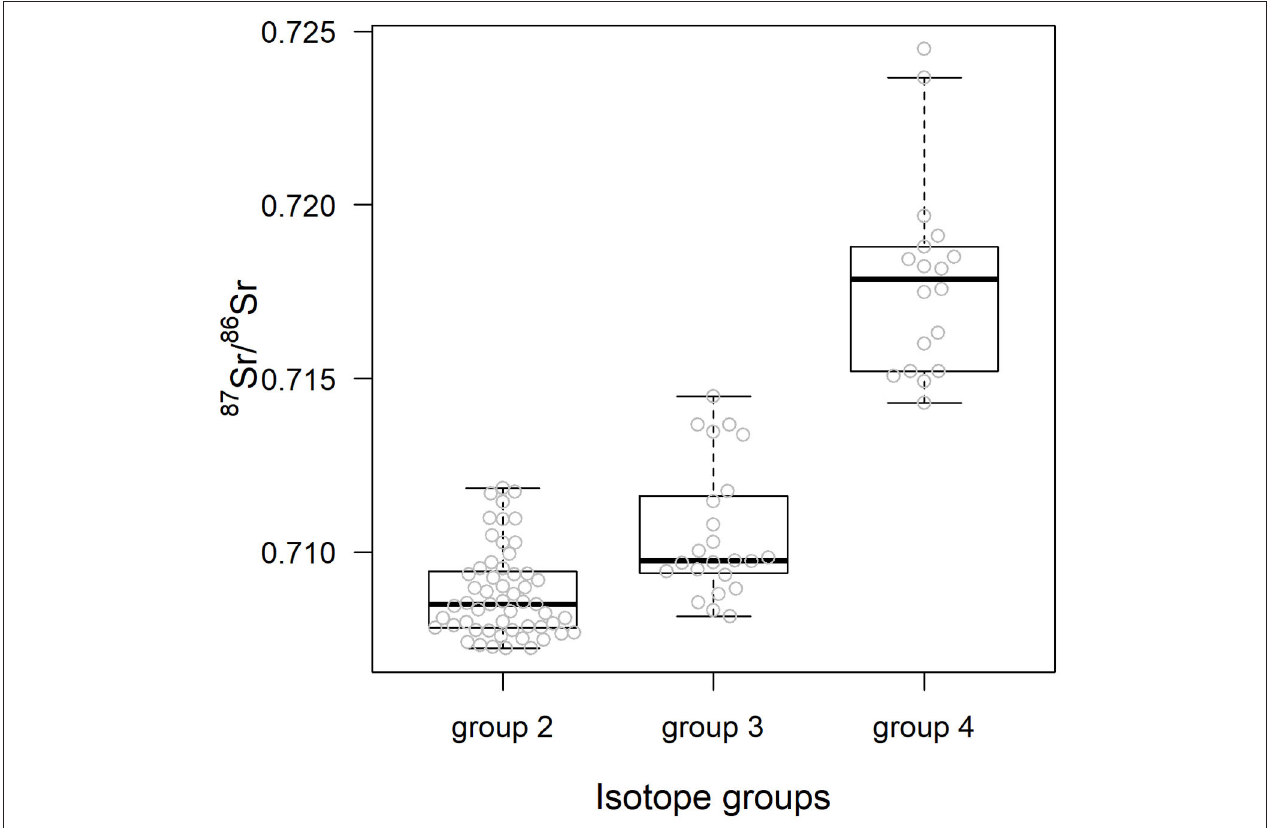
FIGURE 5 | 87 Sr/ 86 Sr values of the biological samples according the isotope group of the lithological unit underlying the sample sites. Center line and box edges are, respectively the median and the 1st and 3rd quartiles, and whiskers represent data points within the range quartile ± 1.5*(interquartile range). Raw values are displayed with gray dots.